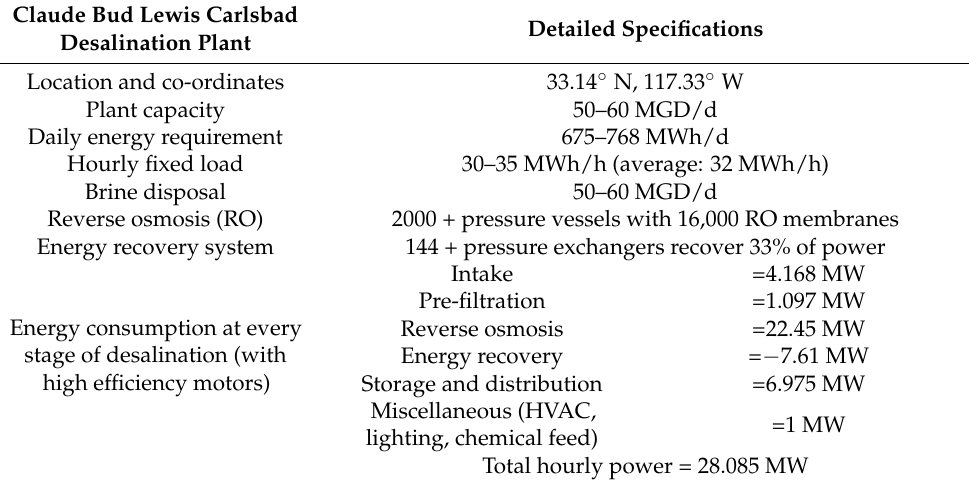
Table 1. Claude Bud Lewis Carlsbad Desalination Plant information [54].